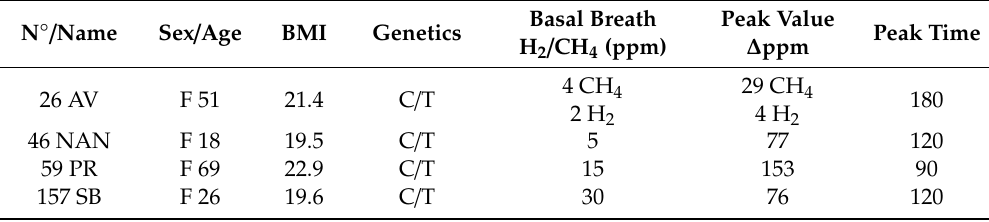
Table 1. Anagraphic, morphologic, and breath test details of the four C / T subjects in whom LBT and genetics are not congruent. Case N ◦ 26 is methane producer and H 2